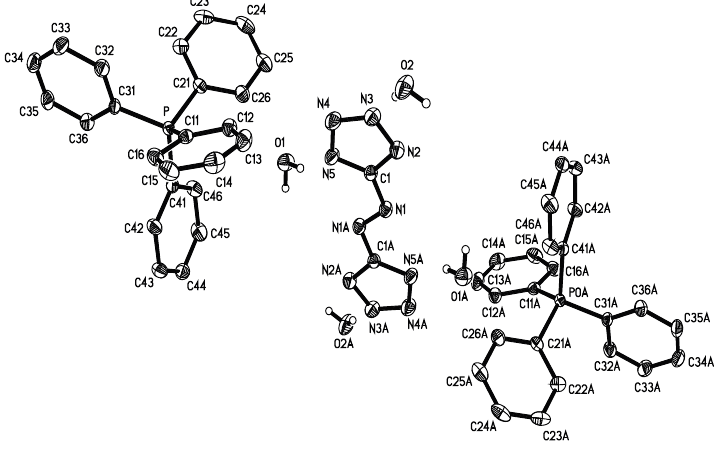
Figure 2. Molecular structure of 1 in the crystal, showing the atom-labeling scheme. Displacement ellipsoids are drawn at the 50% probability level. Selected bond lengths (Å) and angles (°): N(1)–N(1A) 1.256(4), N(2)–N(3) 1.338(3), N(3)–N(4) 1.326(3), N(4)–N(5)